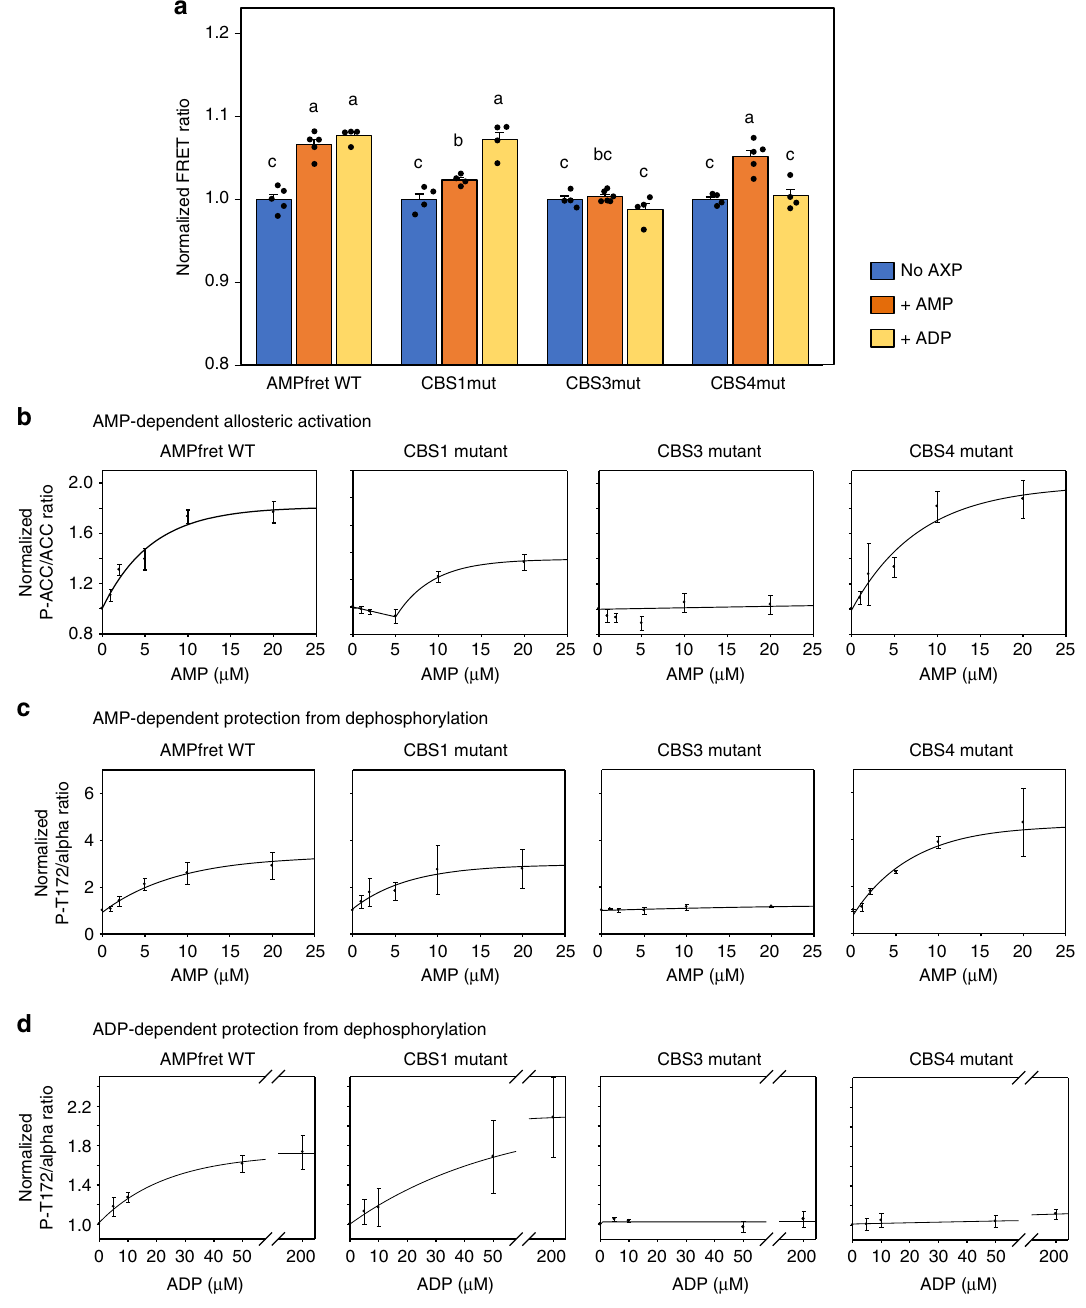
Fig. 3 Deciphering allosteric activation and protection against dephosphorylation. a FRET ratios of AMPfret 1.0 wild type (WT) and corresponding CBS site mutants in presence of AMP (30 μ M, orange bars) or ADP (200 μ M, yellow bars) were normalized to the adenylate-free control (blue bars). Data and error bars represent mean ± SEM ( n ≥ 5). b AMP-induced allosteric activation of AMPfret WT and its CBS site mutants. AMPK activity was quanti fi ed with increasing concentrations of AMP and fi xed MgATP (200 µ M) by immunoblotting for phosphorylated acetyl-CoA carboxylase (P-ACC; see Supplementary Fig. 5) and data normalized to kinase activity in absence of AMP. Data and error bars represent mean ± SEM ( n = 3). c , d AMP- and ADP-dependent protection against dephosphorylation of AMPfret WT and its CBS site mutants. AMPK activity was quanti fi ed with pre-phosphorylated AMPK, phosphatase PP2C α and increasing concentrations of AMP or ADP by immunoblotting for α -subunit P-T172 (see Supplementary Fig. 5) and data normalized to dephosphorylation in absence of ADP. Data and error bars represent mean ± SEM ( n = 3). After checking normality and equality of variance, statistical signi fi cance was analysed by two-way ANOVA followed by Student – Newman – Keuls multiple comparison. Means sharing the same letter do not differ signi fi cantly ( p ≤